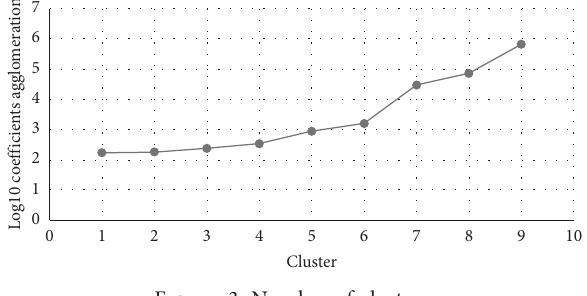
Figure 3: Number of